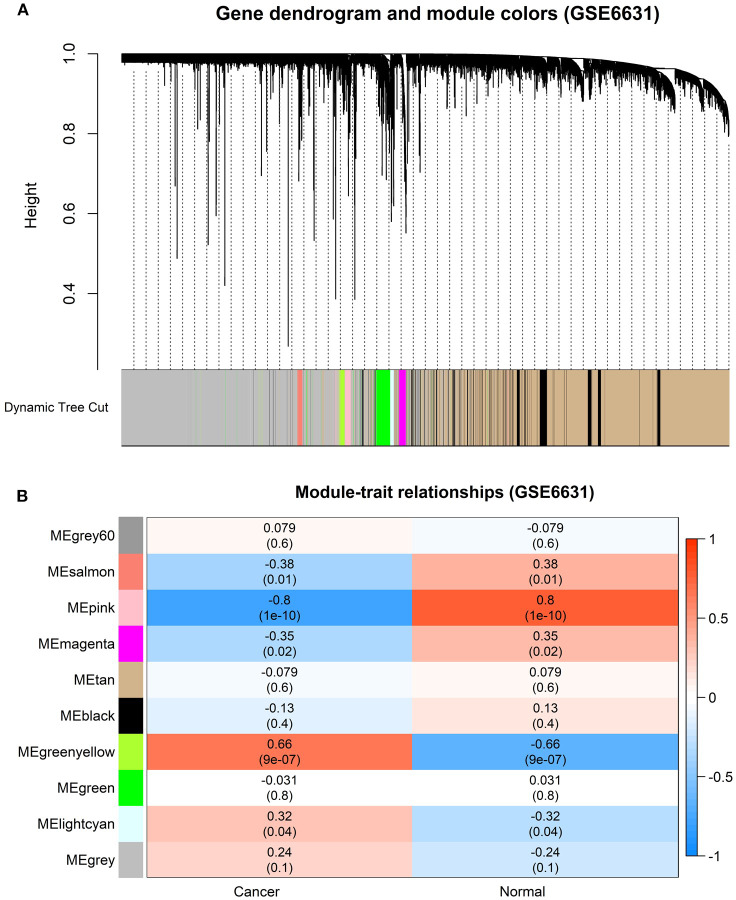
Identification of modules associated with clinical information in the GSE6631 dataset. (A) The Cluster dendrogram of co-expression network modules was ordered by a hierarchical clustering of genes based on the 1-TOM matrix. Each module was assigned different colors. (B) Module-trait relationships. Each row corresponds to a color module and each column correlates to a clinical trait (cancer and normal). Each cell contains the corresponding correlation and P-value.